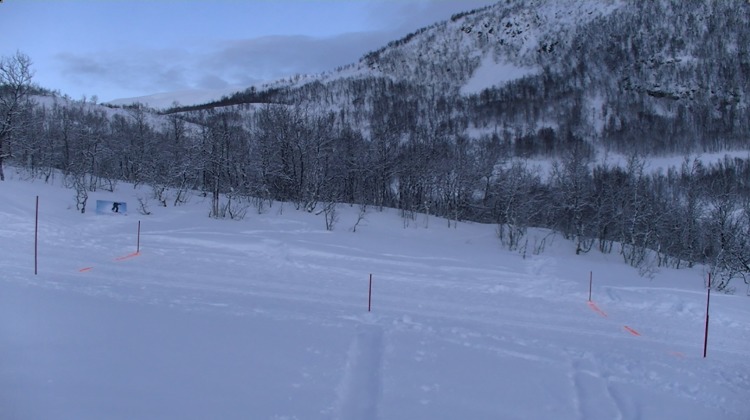
The sections video-recorded, showing the four red poles creating a perfect rectangle, the fifth pole set exactly in the middle of this rectangle, and the two orange lines drawn on the snow between the poles perpendicular to the ski track.This arrangement allowed appropriate calibration of the track chosen by each skier individually. This image was taken by the camera on the uphill section.